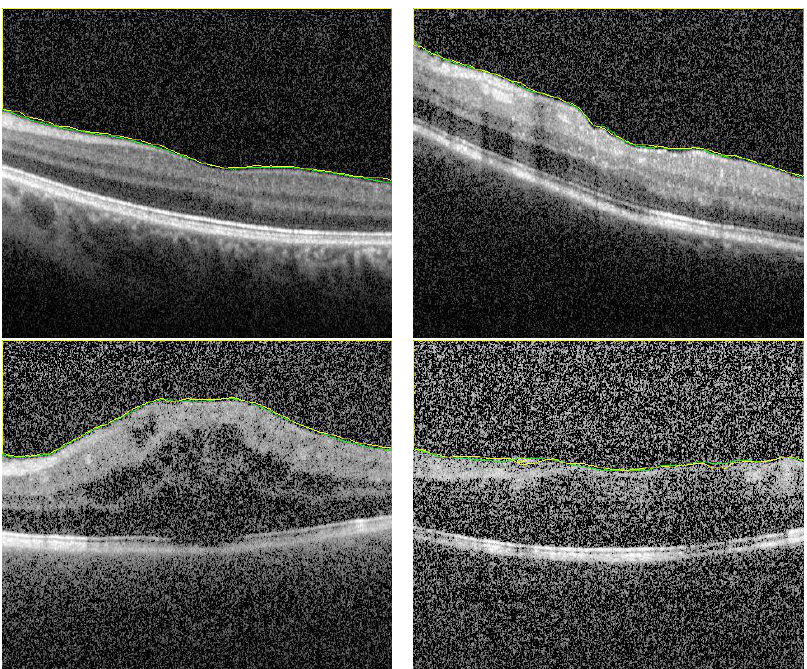
Figure 5. Sample of high accuracy segmentation. The first row represents grayscale images with high contrast, and the second row represents low contrast images with higher degree of vitreous inflam- mation. Green and yellow colors represents the ground truth and the CNN segmented respectively.